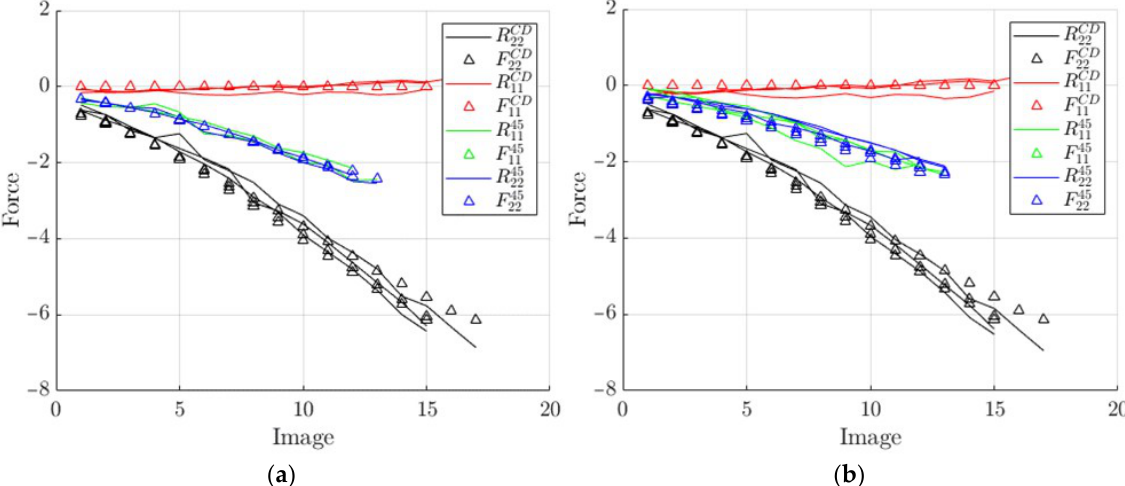
Figure 16. Curves reconstructed from the identified A matrix vs. measured force: ( a ) using tests in group 1; ( b ) using tests in group 2.